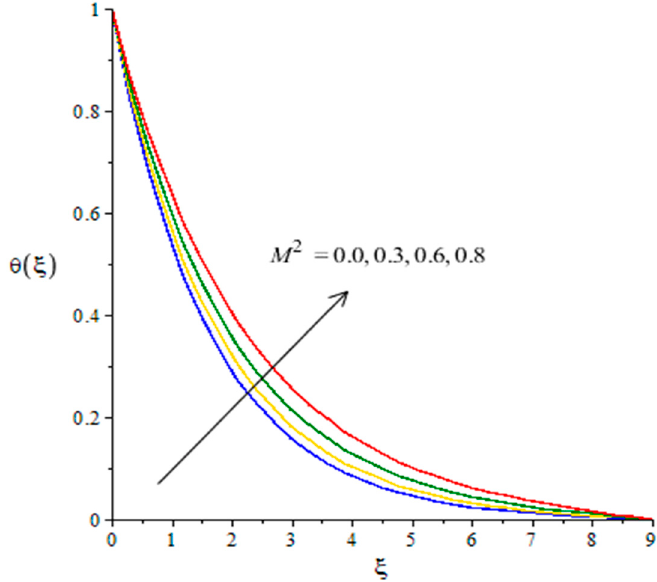
Figure 16. Comparative investigation among fluid, nanoparticles, hybrid nanoparticles and tri-hy- brid nanoparticles on temperature profile when 𝑚 = 0.1, 𝑊𝑒 = 5, Ω = 2.0, 𝑀 (cid:2870) = 0.3,𝛽 (cid:3032) = 0.5, 𝛽 (cid:3036) = 0.7, 𝜖 = 0.01, 𝐹 (cid:3045) = 2.5, 𝑃𝑟 = 204, 𝐸𝑐 = 0.54,𝜑 (cid:2870) = 0.0075, 𝜑 (cid:2869) = 0.002,𝜑 (cid:2871) = 0.005.